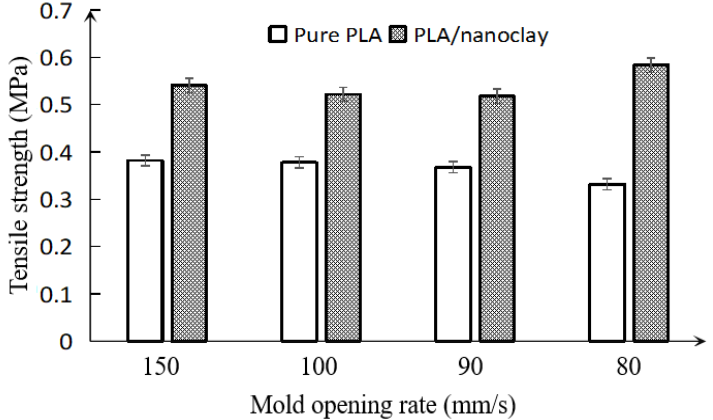
Figure 6. Variation of the impact resistance of pure PLA and PLA–nanoclay foamed samples with various mold opening rates.